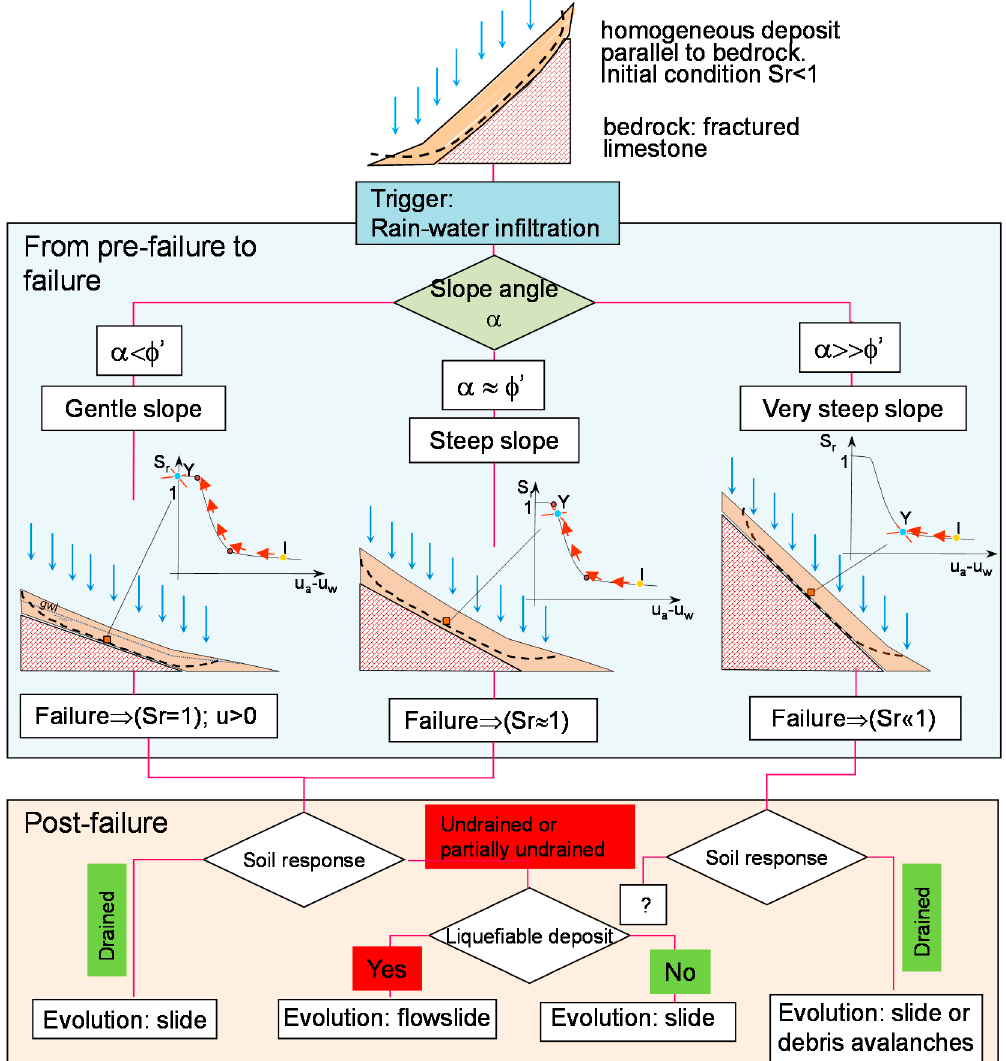
Figure 10. Flowchart to predict the development of rainfall-induced landslides (after Olivares and Damiano, [6]).